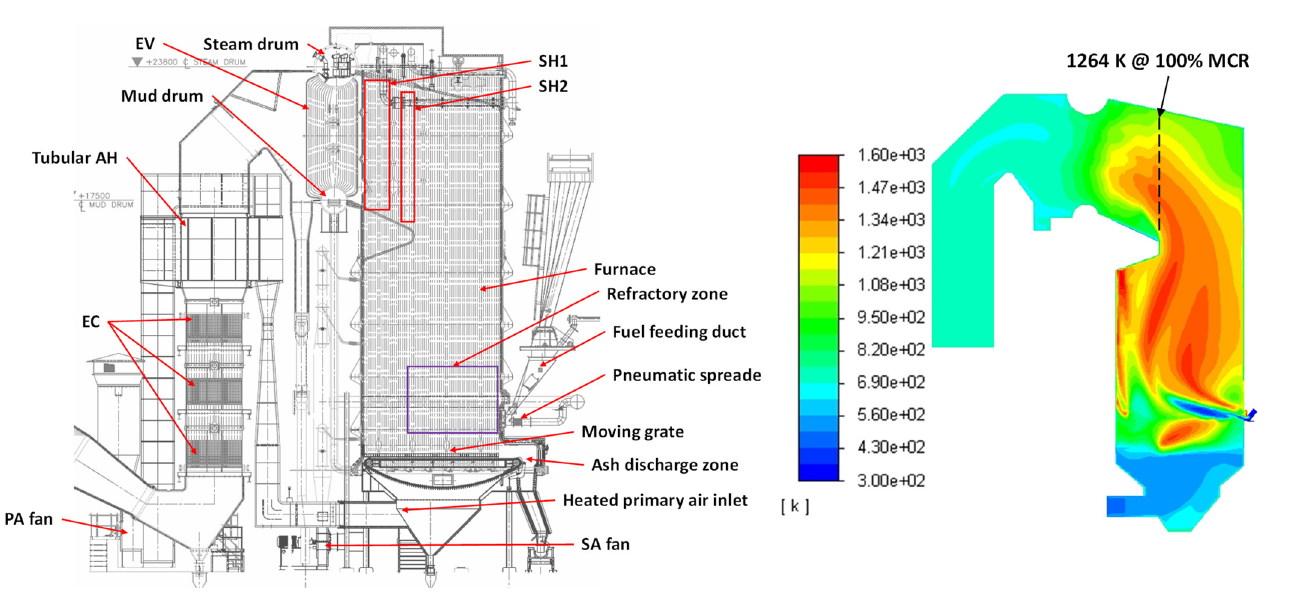
Figure 10. Industrial biomass boiler general arrangement ( left ) [3]; contour of gas temperatures for 100% case, calculated using CFD ( right ). Table 6. Biomass fuel composition (from actual fuel analysis).